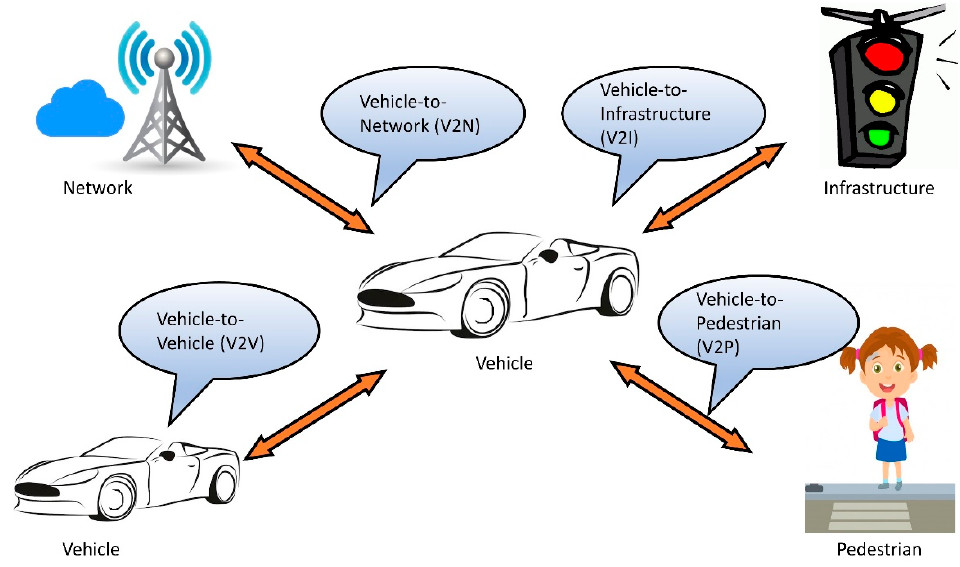
Figure 1. Constituents of V2X communication .